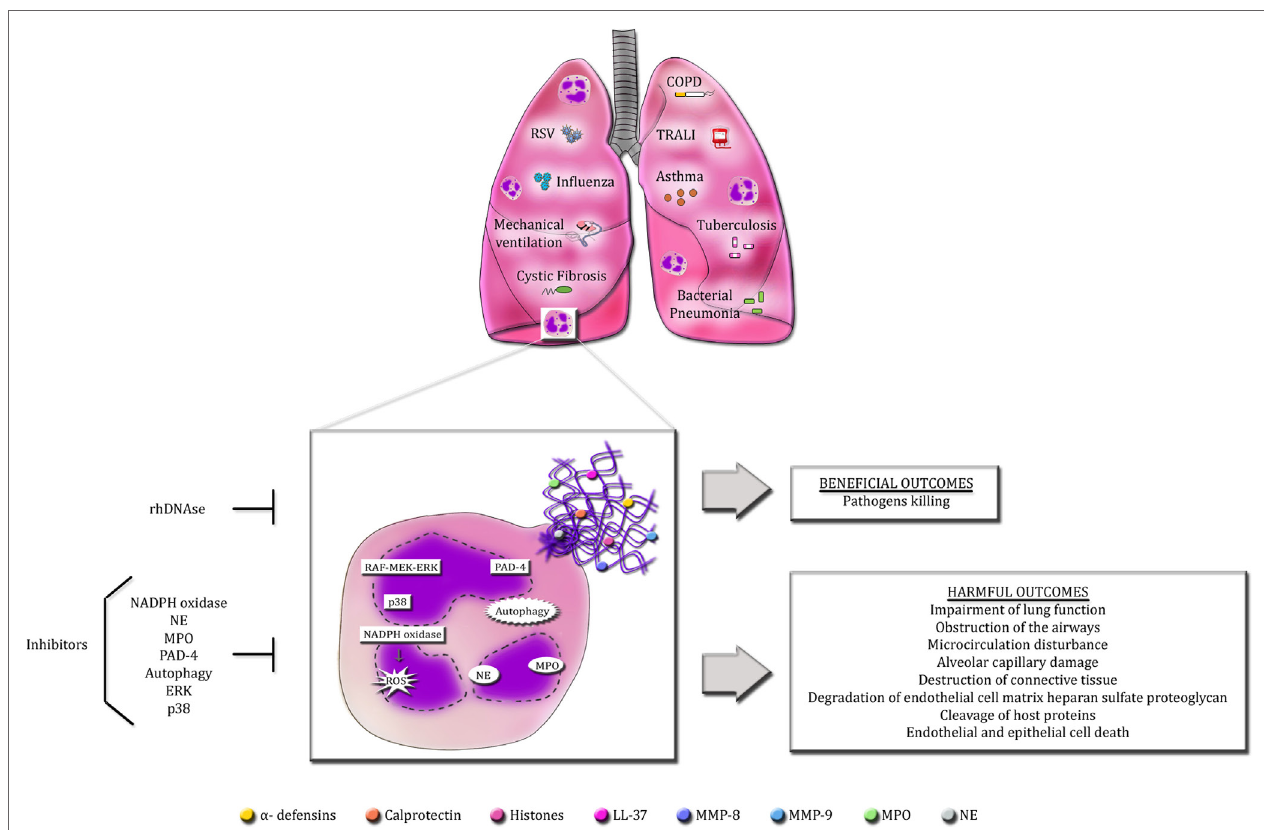
FiGURe 1 | Overview of the beneficial and detrimental roles of NeTs in pulmonary diseases . Infectious and non-infectious pulmonary diseases cause the massive infiltration of neutrophils into the lungs. Activated neutrophils release an excess of NETs in the airways. The production of NETs requires the activation of specific signaling pathways described so far, such as raf-MEK-ERK and p38 MAPK, PAD-4, autophagy and NADPH oxidase-induced ROS generation. Additionally, NE and MPO also regulate NET formation. Accordingly, selective inhibitors of these signaling pathways are able to abolish or decrease NET release. The primary goal of NETs is to protect the host from invading microorganisms through their sticky nature and the high concentrations of antimicrobial proteins. However, these characteristics make NETs potentially detrimental to host cells and tissues. Excessive NET formation enhances mucus viscosity, filling the lungs, and impairing lung function. NET proteins are highly cytotoxic and can induce endothelial and epithelial cell death and cause the disruption of host proteins and cellular